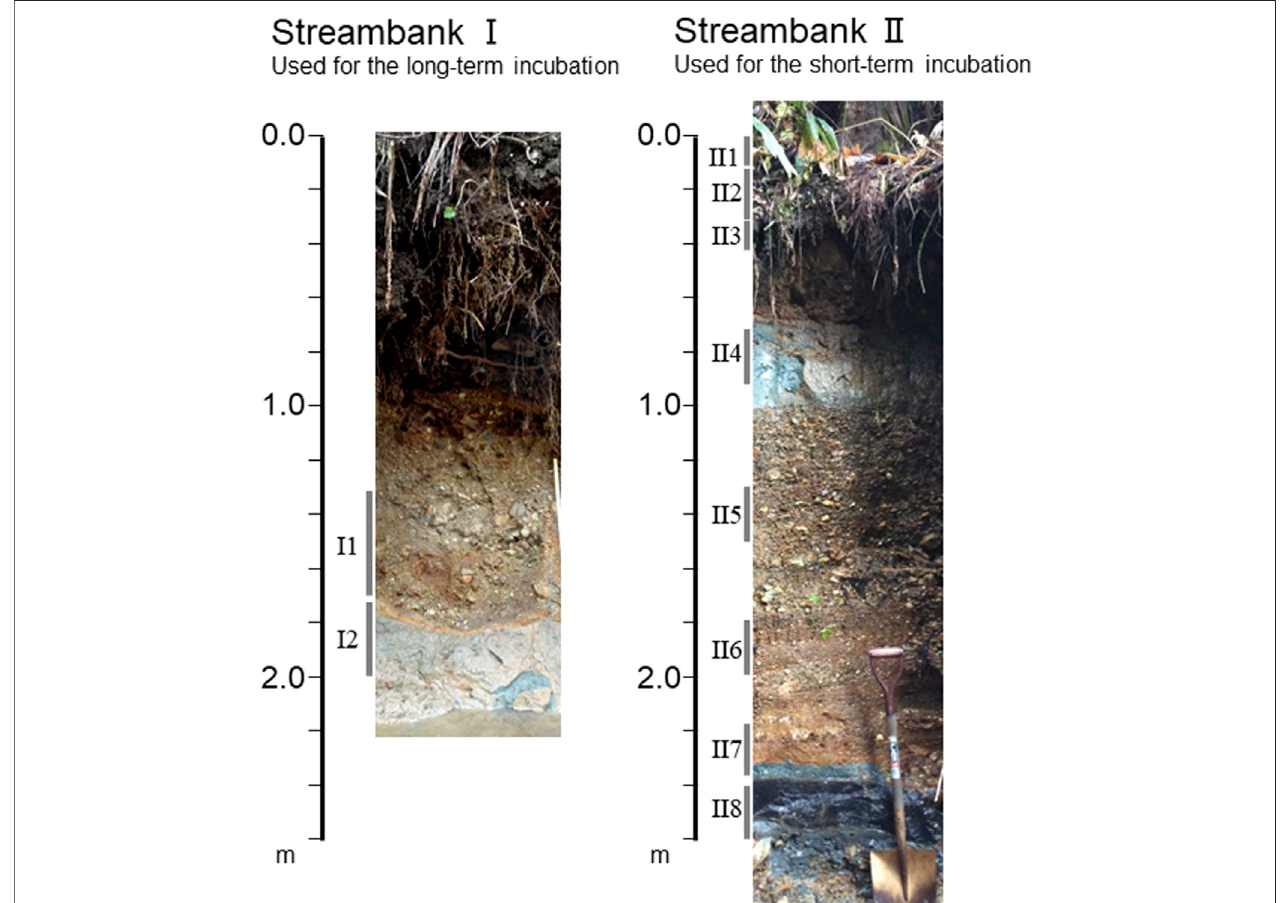
FIGURE 2 | Streambanks I and II at St. 15, and the depths of the soils sampled for the incubation experiments.